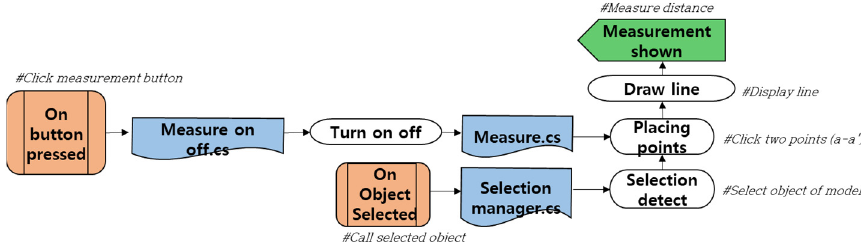
Figure 11. Algorithm to develop measurement function.